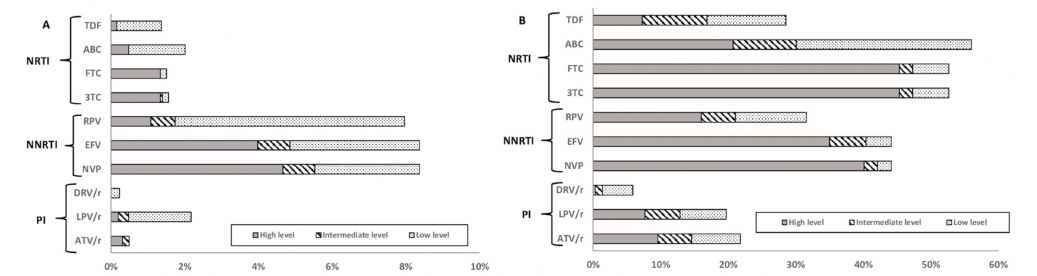
Figure 3. Predicted phenotypic resistance (Stanford scores) for antiretroviral drugs